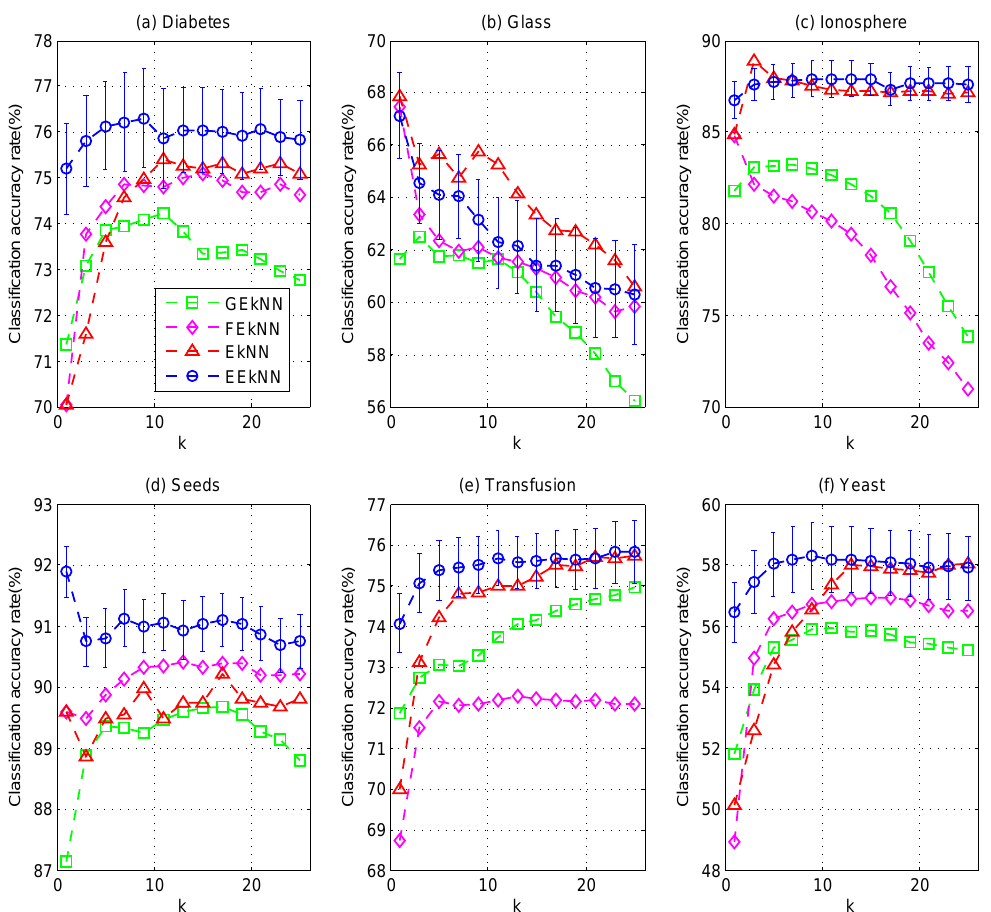
Figure 8. Classification results of different methods for real